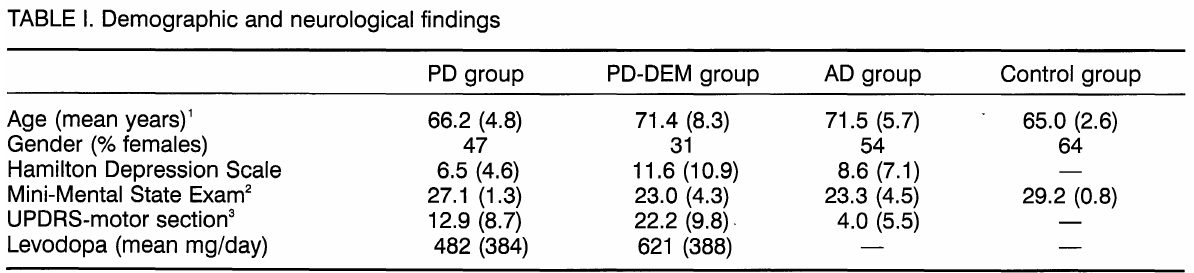
TABLE I. Oemographic and neurological findings